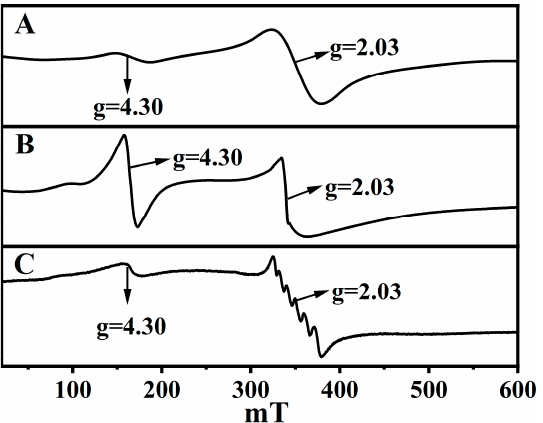
Figure 5. EPR spectra acquired at 77 K for Fe(0.03) − H(0.05) − CP − 3 ( A ), Fe(0.03) − H(0.05) − CP − 9 ( B ), and ( C ) Fe(0.03) − H(0.00) − CP − 9.